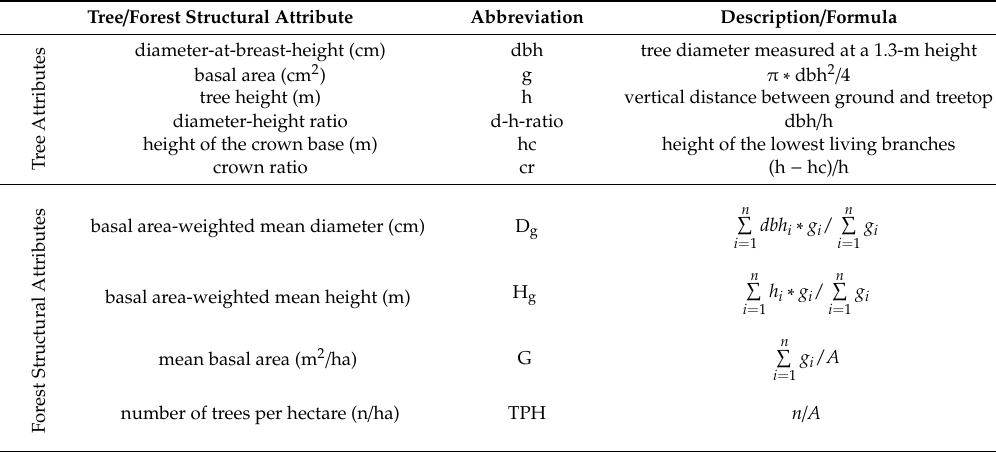
Table 2. Description of the attributes used in this study to characterize trees and forest structure in 2014 (T1) and 2019 (T2). A = sample plot area in hectares, n = number of trees within a sample